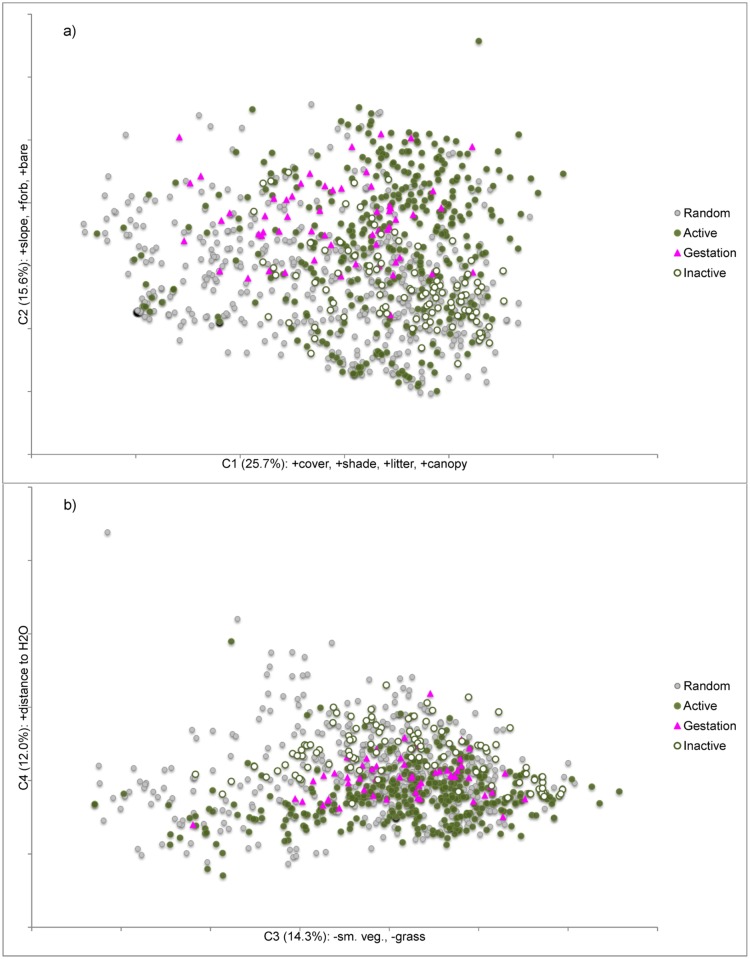
Biplots of four habitat components generated from PCA analyses.a) C1 (cover and litter) vs. C2 (slope, forb, and bare ground cover) and b) C3 (small-diameter vegetation abundance) and C4 (distance to water). Percentages in parentheses show the amount of variation in the data accounted for by that component.